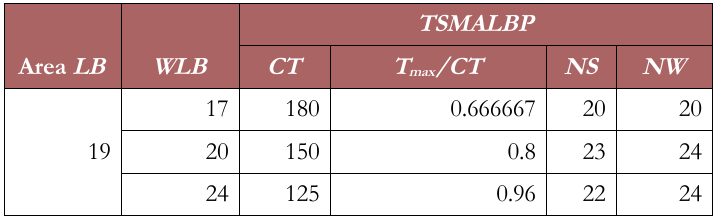
Table 7. The results of real-life problem of Nissan plant in Spain by varying the CT